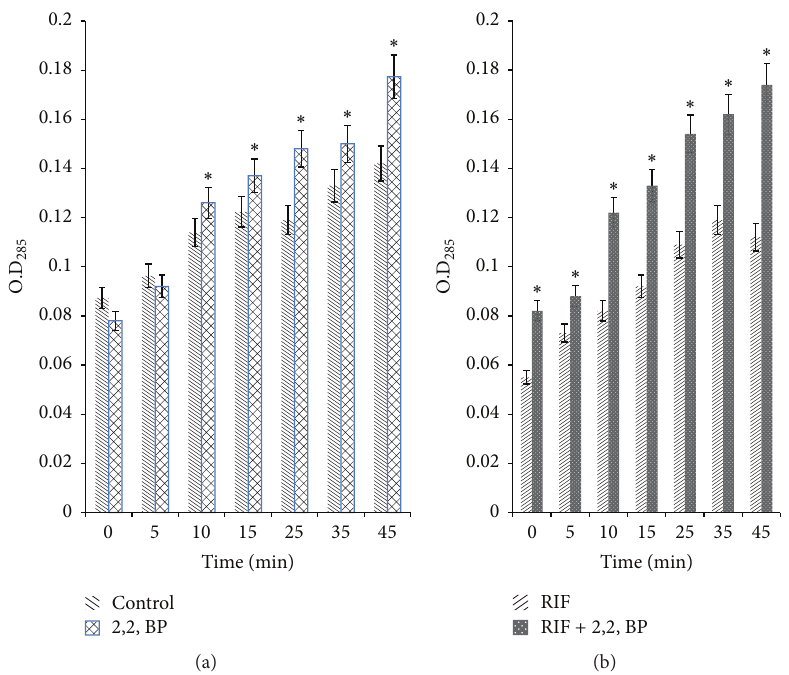
Figure 6: Passive diffusion in response to iron deprivation. (a) Passive diffusion displayed by extracellular concentrations of EtBr for M. smegmatis cells grown in the absence (control) and the presence of 2,2, BP (35 𝜇 g/mL) as described in Section 2. Means of O.D 285 ± SD of three independent sets of experiments are depicted on 𝑦 -axis with respect to time (minutes) on 𝑥 -axis ( ∗ depicts significant difference with 𝑃 < 0.05 ). (b) Passive diffusion displayed by extracellular concentrations of EtBr for M. smegmatis cells grown in RIF alone (control) and in the presence of 2,2, BP (35 𝜇 g/mL) as described in Section 2. Means of O.D 285 ± SD of three independent sets of experiments are depicted on 𝑦 -axis with respect to time (minutes) on 𝑥 -axis ( ∗ depicts significant difference with 𝑃 < 0.05